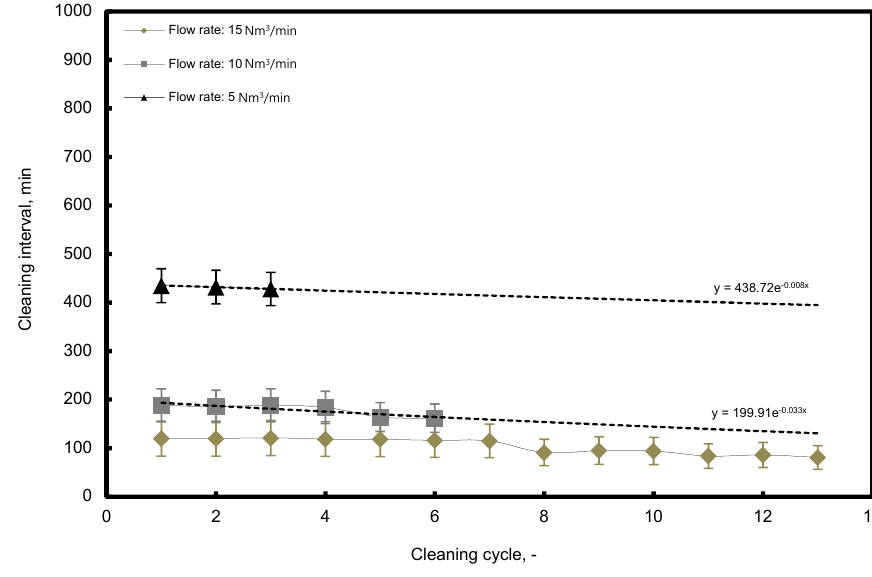
Figure 5. Cleaning interval results with the flow rate variable.